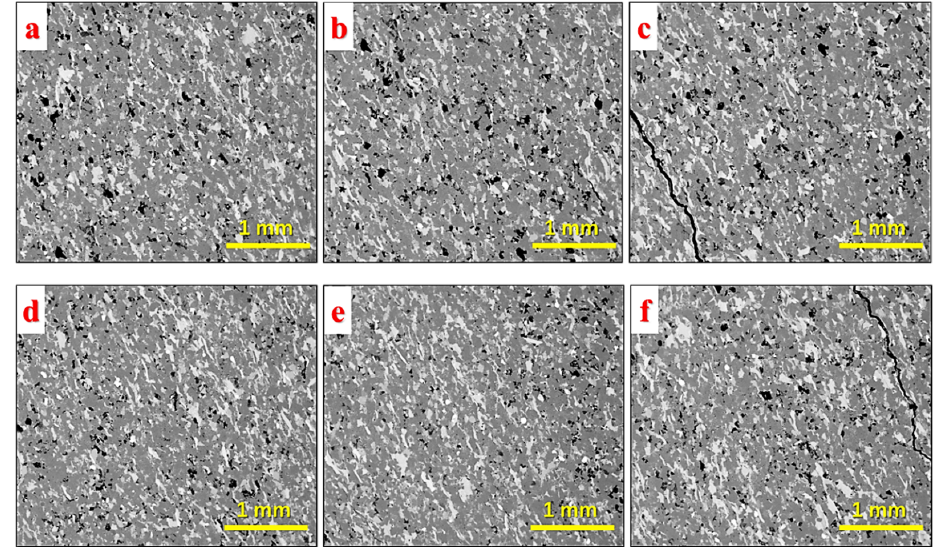
Figure 4. Field emission SEM observation of samples a–f.